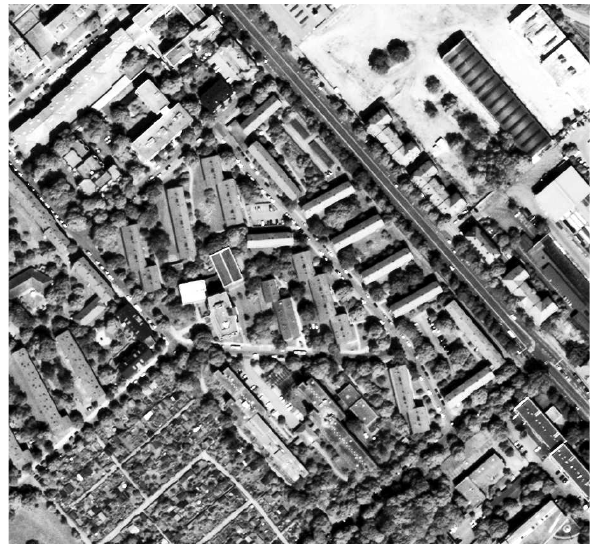
Figure 6: High resolution Pan-chromatic image J Image